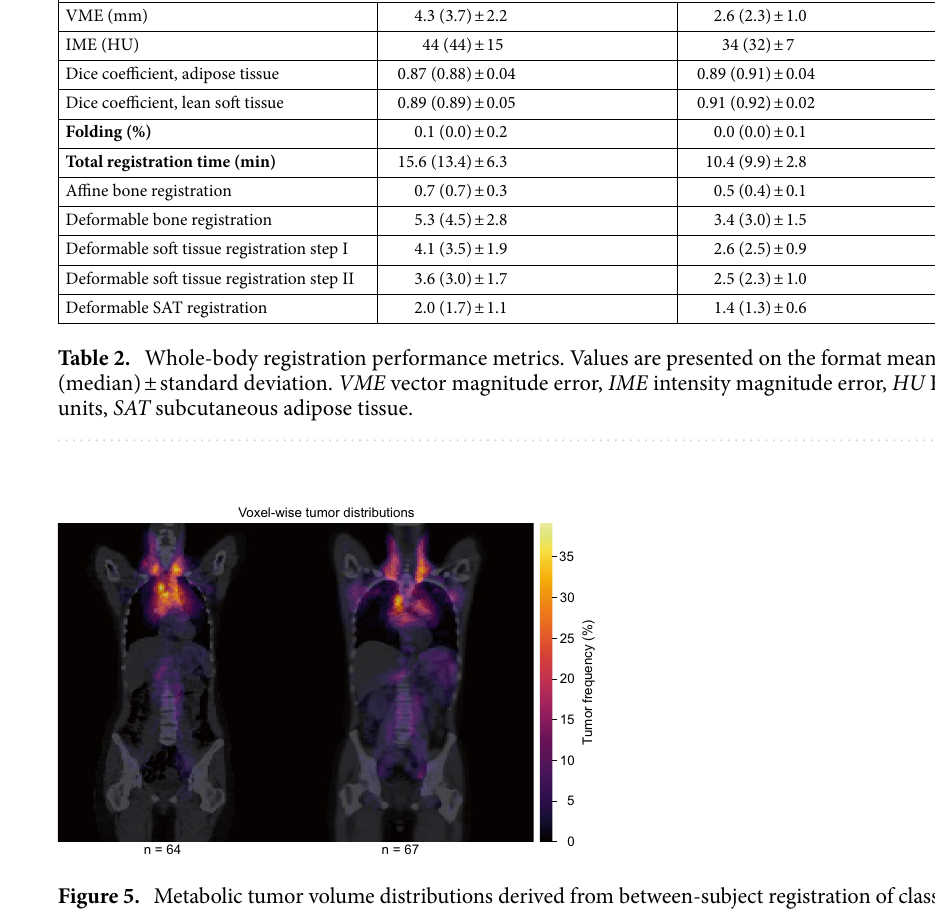
Figure 5. Metabolic tumor volume distributions derived from between-subject registration of classical Hodgkin lymphoma patients. Distributions are presented as maximum intensity projections overlaid in color on mid-coronal planes of the chosen female (left) and male (right) template CTs. The number of subjects in each subset is shown below the